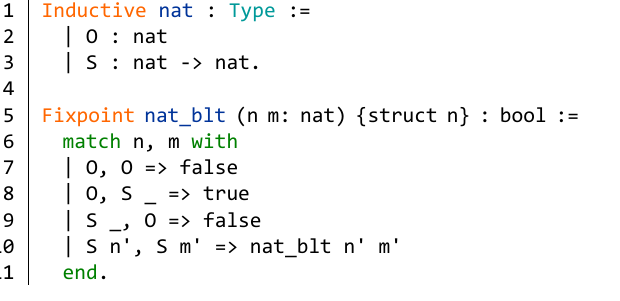
Figure 2. Examples of formal development in